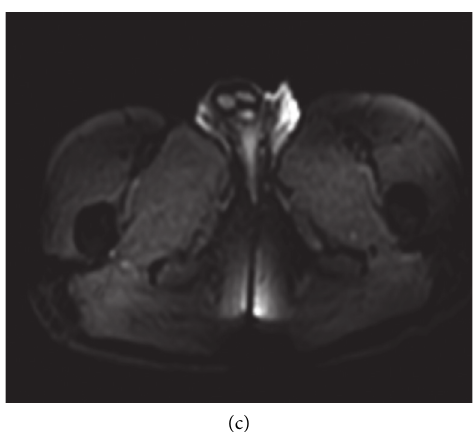
Figure 3: Inguinoscrotal MRI showing the exo- and endophytic inguinoscrotal tumor with intermediate signal intensity on T2-weighted sequences ((a), arrow) enhanced ((b), star) with diffusion restriction